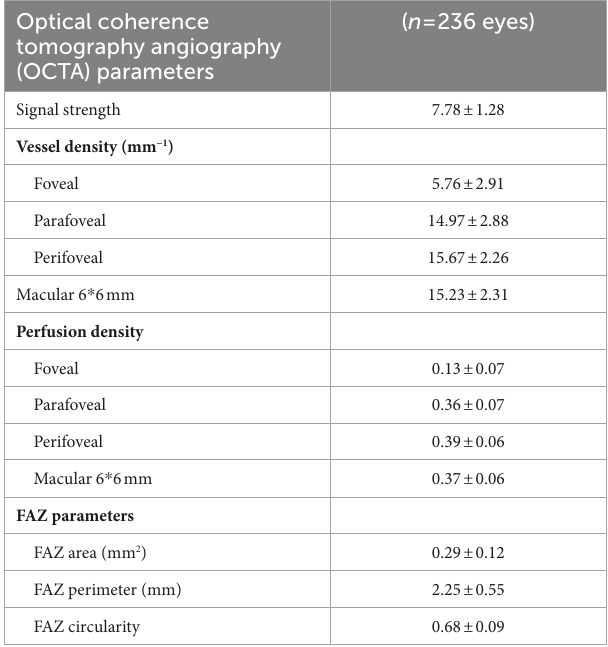
capillary plexus and foveal avascular zone (FAZ) measurements. Optical coherence tomography